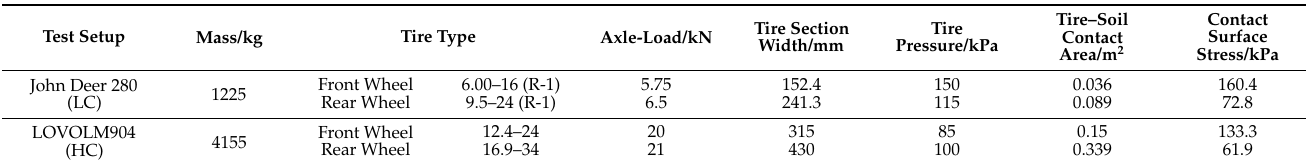
Table 2. Test tractor tire